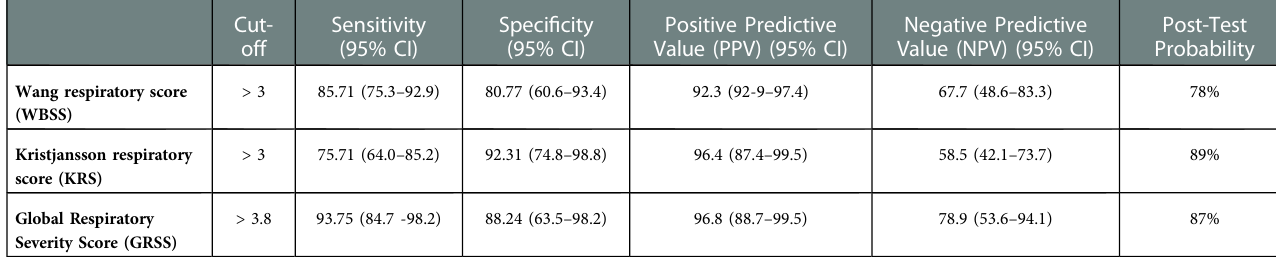
TABLE 5 Sensitivity, speci fi city, and positive and negative predictive value for the need of respiratory support (HFNC, nCPAP or mechanical ventilation) of the three bronchiolitis scores (WBSS, KRS, GRSS) at the optimal cut-off